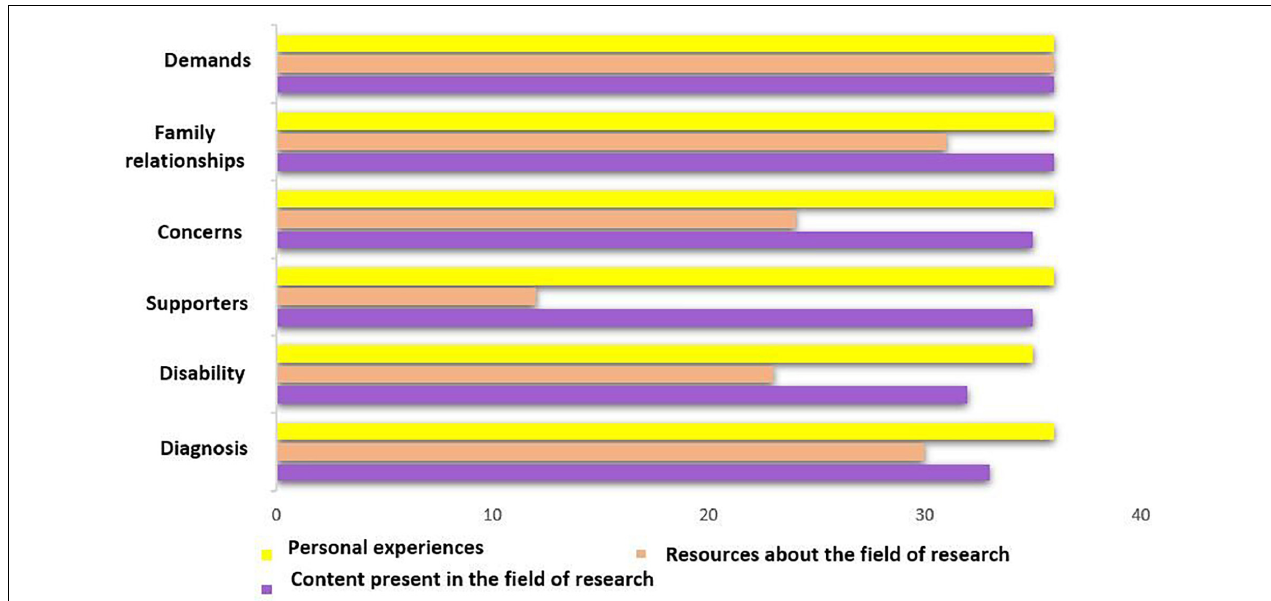
FIGURE 3 | Analysis of the presence of content by